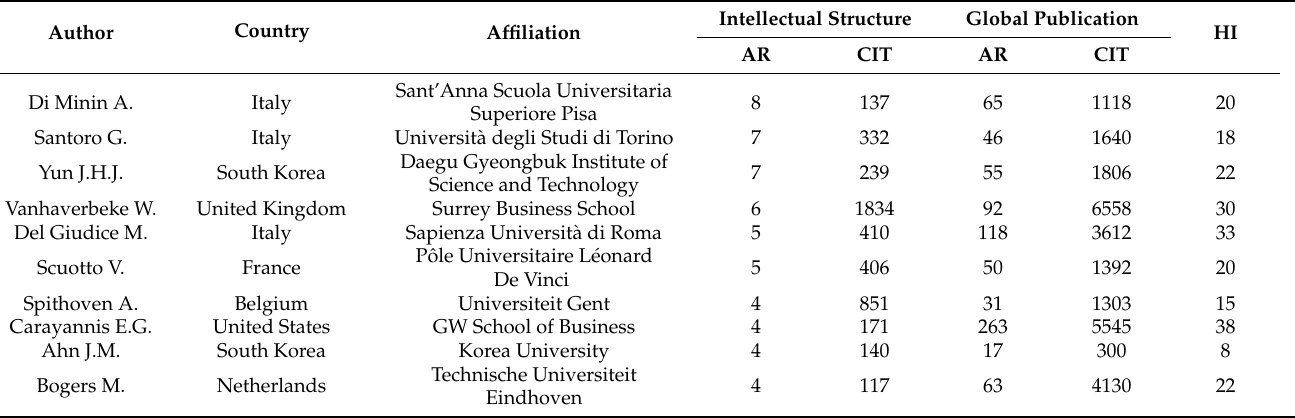
Table 1. Top 10 most productive